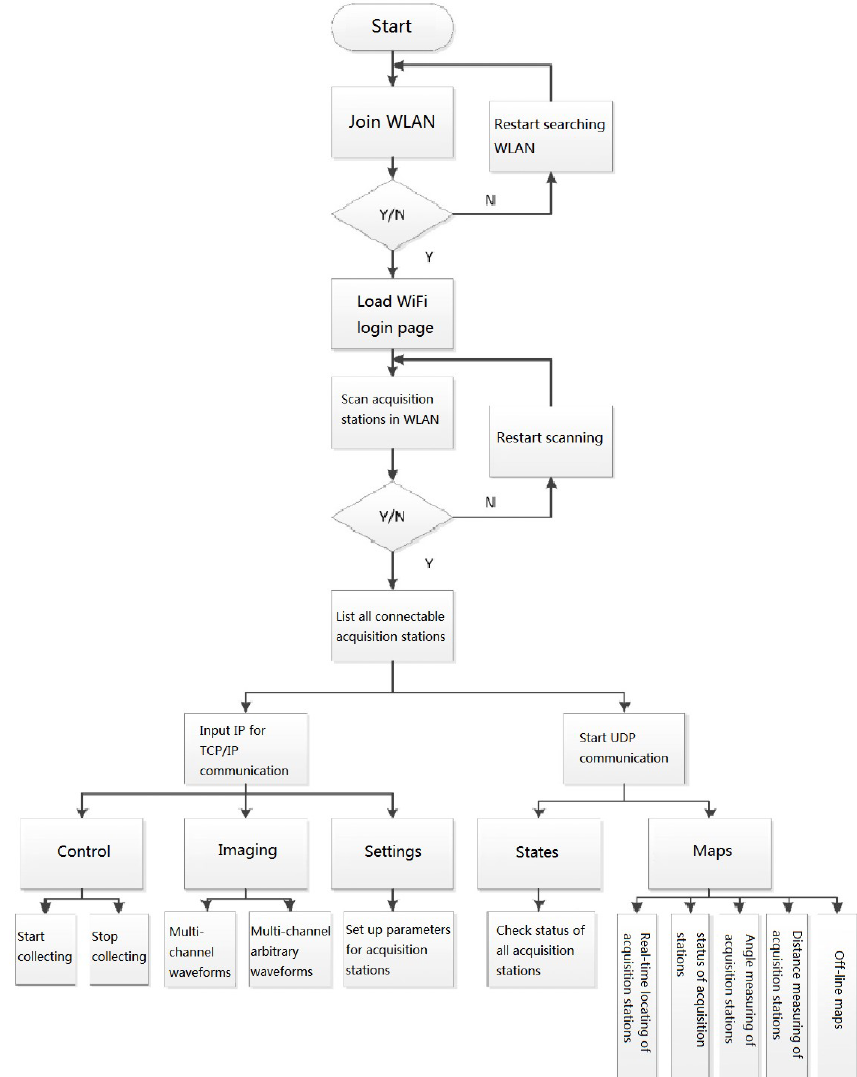
Figure 3. Main process of the